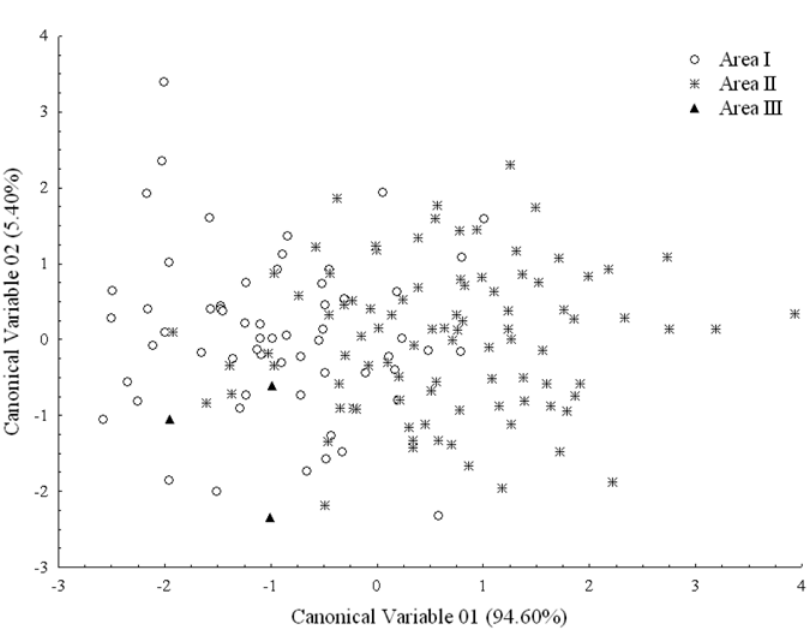
Fig. 6 - Graphic dispersion of the population Tetrapedia diversipes in relation to Cartesian axes established by canonical variables (CV1, CV2) obtained from morphological characteristics of